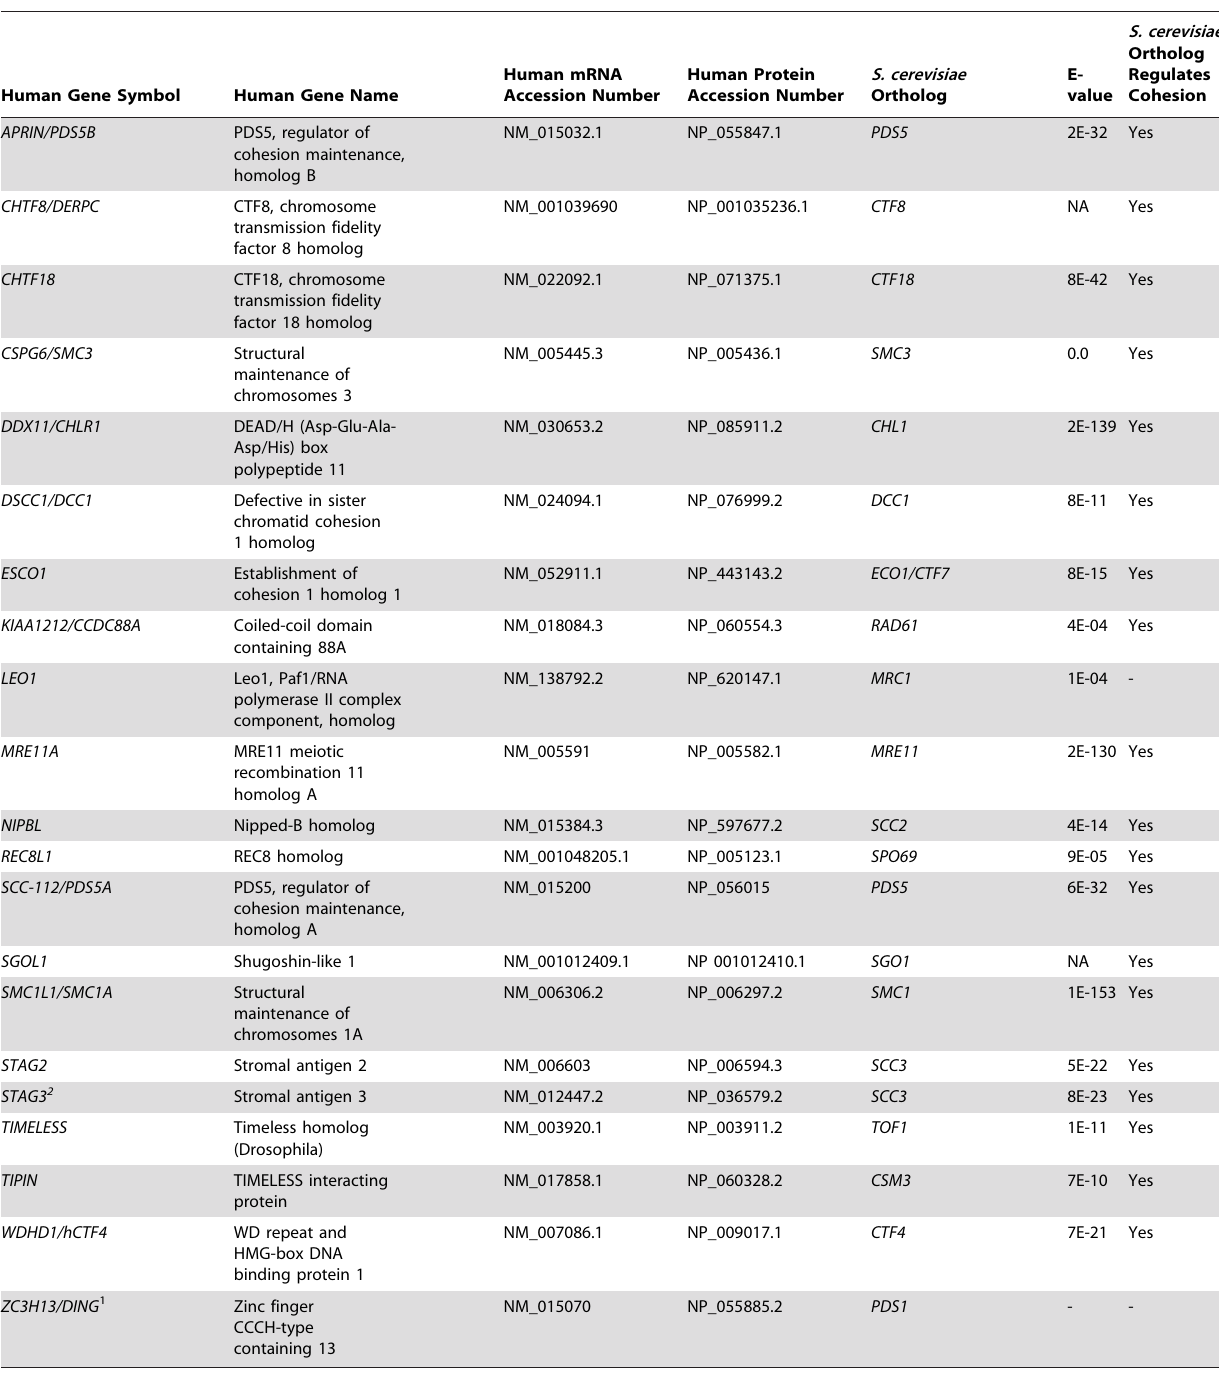
Table 1. Genes resequenced in the mutation discovery screen.